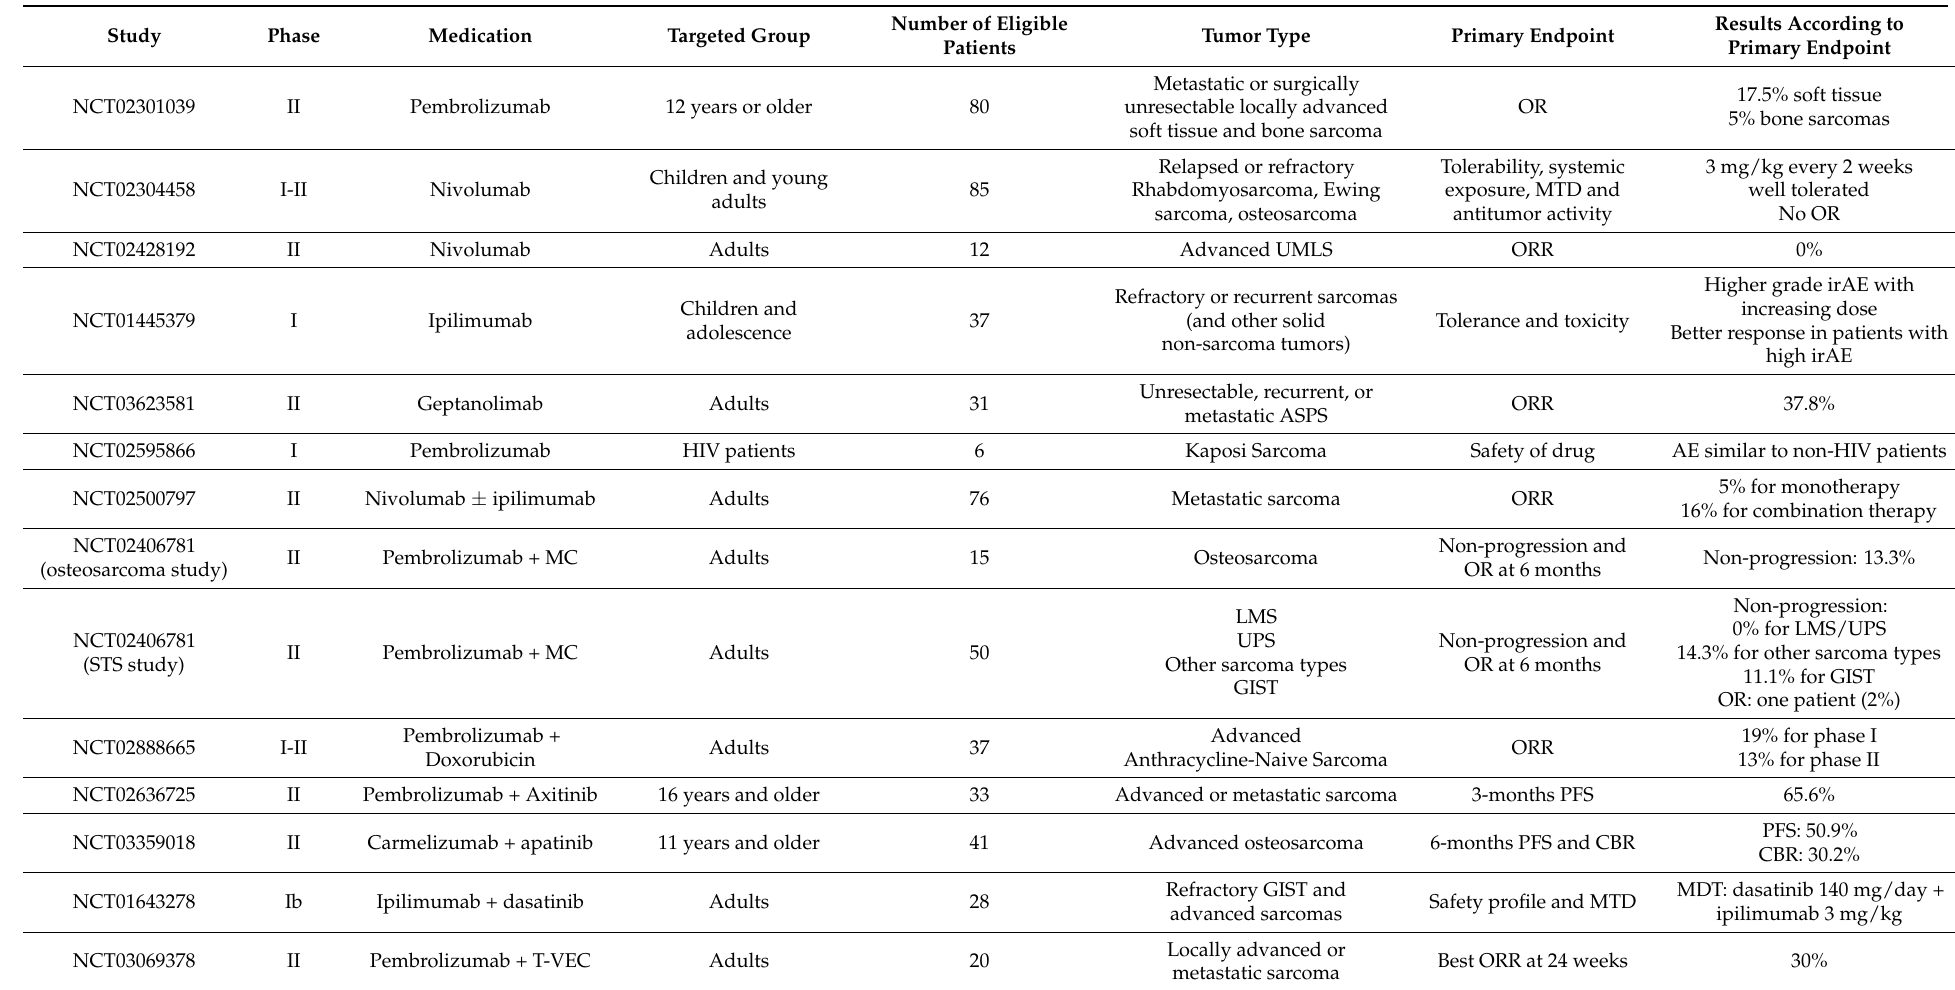
Table 1. This table summarizes all the clinical trials and their results in terms of the primary